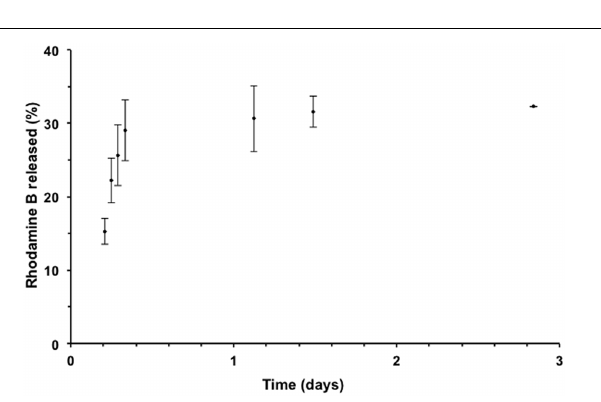
FIGURE 2 | Release profile of Rh B from PLGA NPs in phosphate buffered saline (PBS) solution at 37 ◦ C using dialysis method. Data points are presented as mean ± standard deviation, n =